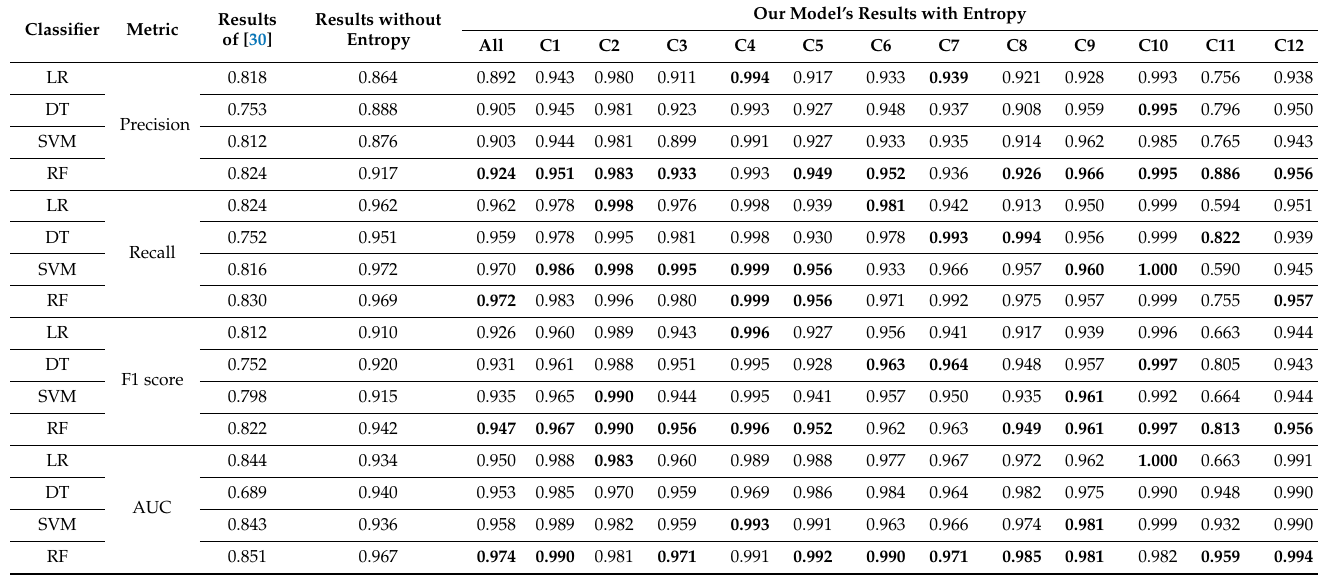
Table 5. The prediction results of all courses